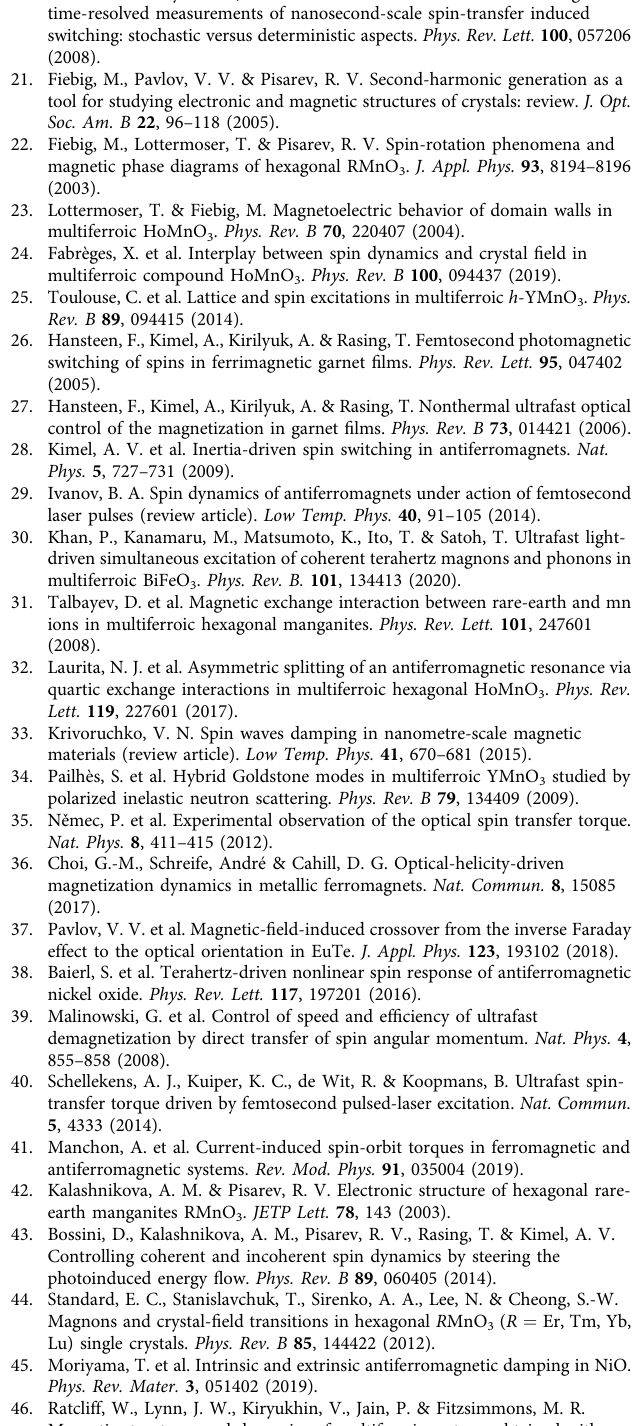
¼ and D z N g μ B ð Þ 2